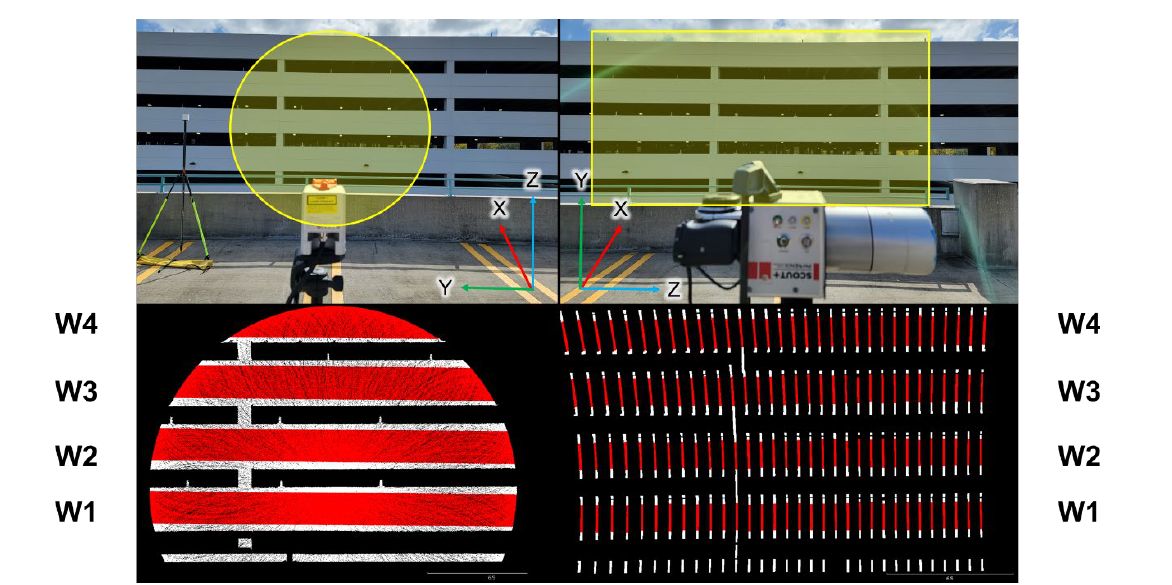
Figure 8. Study site and target surface at the University of Florida. Top: The scanners were oriented at the side of an adjacent parking garage (yellow) at standoff distances to reflect a sUAS topographic data collection. Bottom: Scanner observations relative to each scanner are shown with extracted subsections highlighted in red. In order to facilitate reporting of results, the subsections of the target surface are designated W1 through W4, with W1 being the lowest and W4 being the highest observed by the scanners.